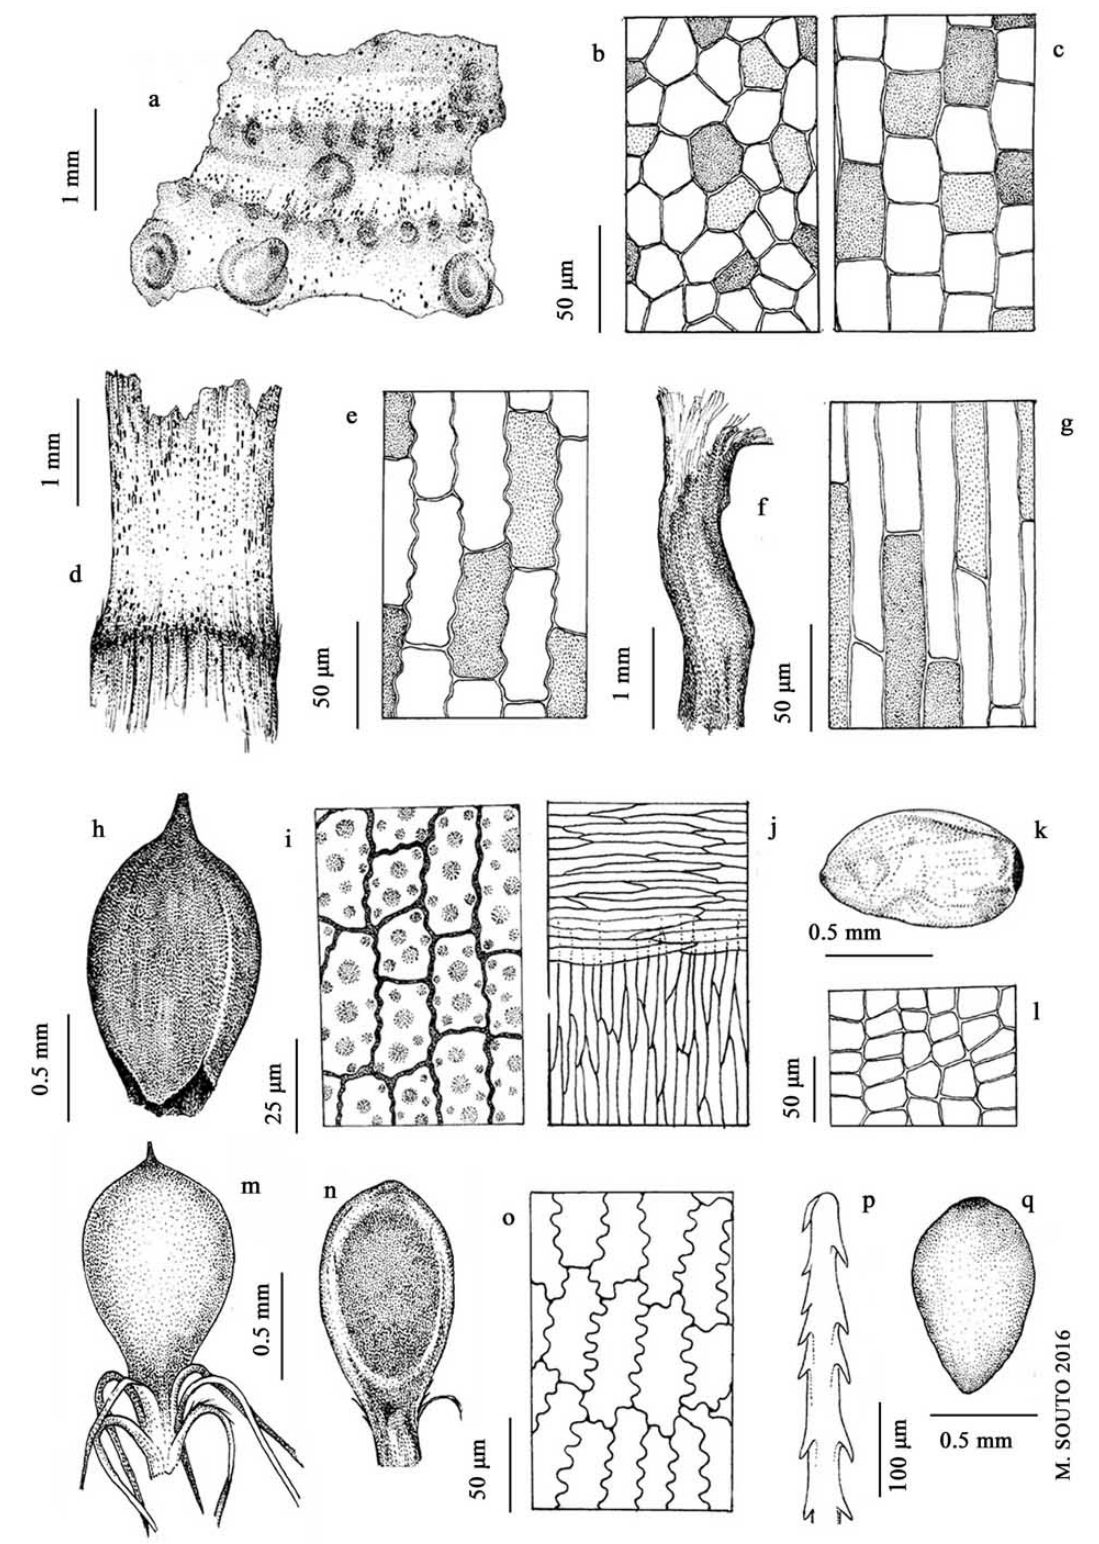
Figure A1. Eriophorum angustifolium : a) rhizome fragment with scars of roots and leaves; b) rhizome epidermal cells; c) epidermal cells of leaf base; d) leaf sheath; e) epidermal cells of leaf blade; f) root fragment; g) root epidermal cells; h) achene with persistent style base; i) outer achene epidermal cells; j) pericarp with two layers of elongated cells arranged perpendicularly; k) seed; l) seed testa epidermal cells. Rhynchospora alba : m) achene with perianth bristles; n) degraded achene with very thin pericarp surrounding the seed; o) outer achene epidermal cells; p) retrorsely barbed perianth bristle; q)